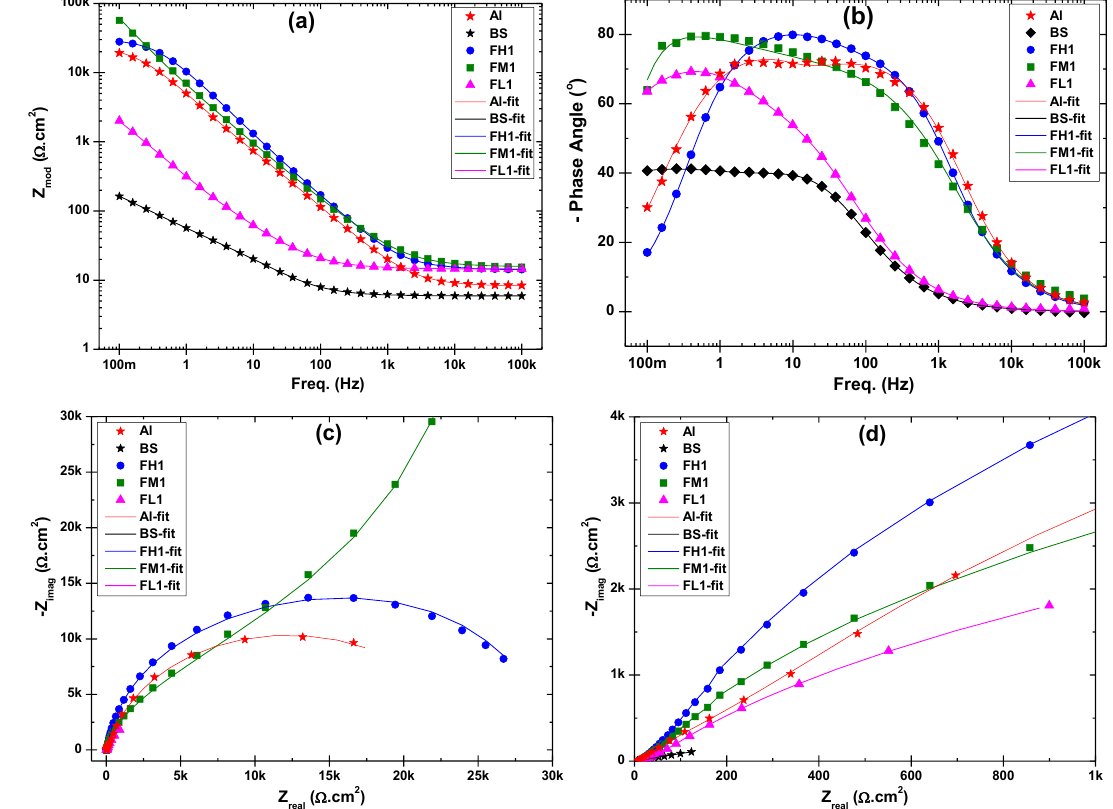
Figure 7. Electrochemical impedance spectroscopy (EIS) curves: ( a ) modulus ( b ) phase angle ( c ) Nyquist plot and ( d ) zoomed-in plot of ( c ), showing the effect of rotation speed after 21 days of immersion in 3.5% NaCl medium.